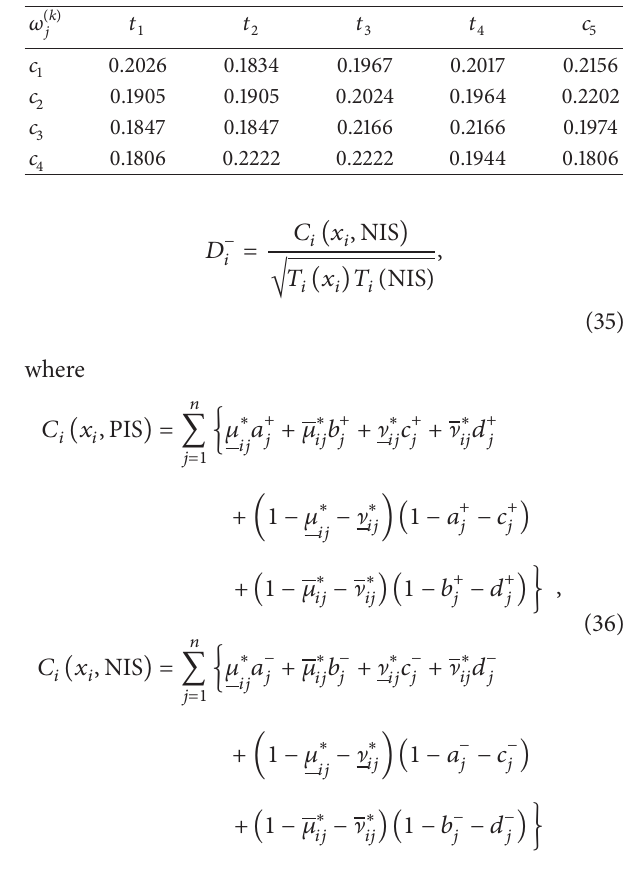
Table 6: Weights of criteria at each time